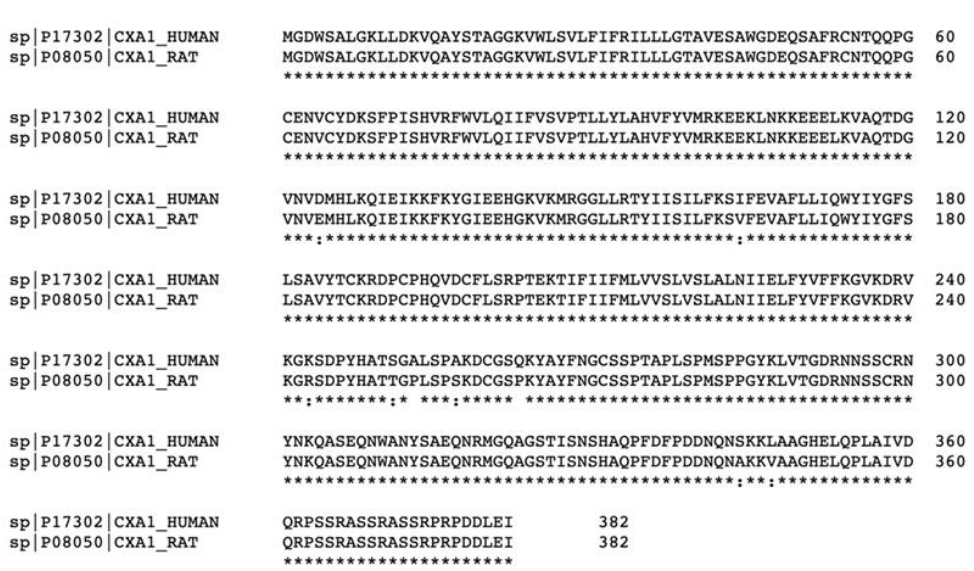
Figure 1. Sequence alignment of human Cx43 (also known as CXA1) and rodent Cx43 showing 97.64% sequence homology. Created with Uniprot.org, accessed on 17 August 2022. An * (asterisk) indicates positions which have a single, fully conserved residue. A : (colon) indicates conservation between groups of strongly similar properties. A . (period) indicates conservation between groups of weakly similar